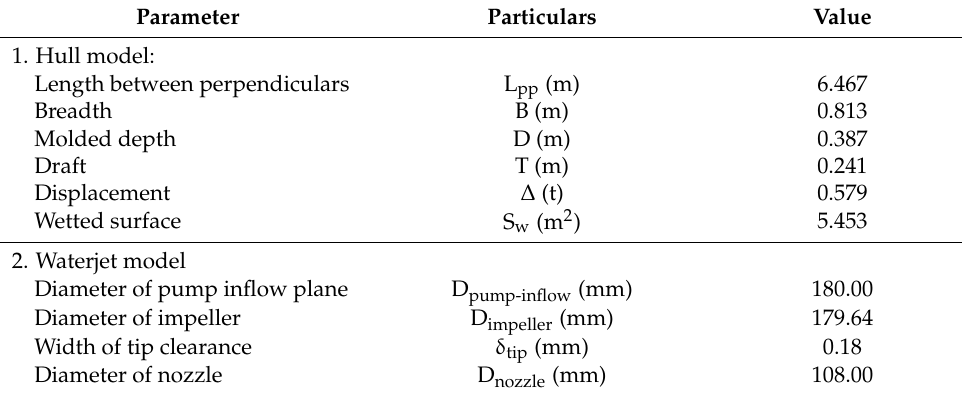
Figure 2. Hull and waterjet geometry. Table 1. Main parameters of the hull and waterjet models.